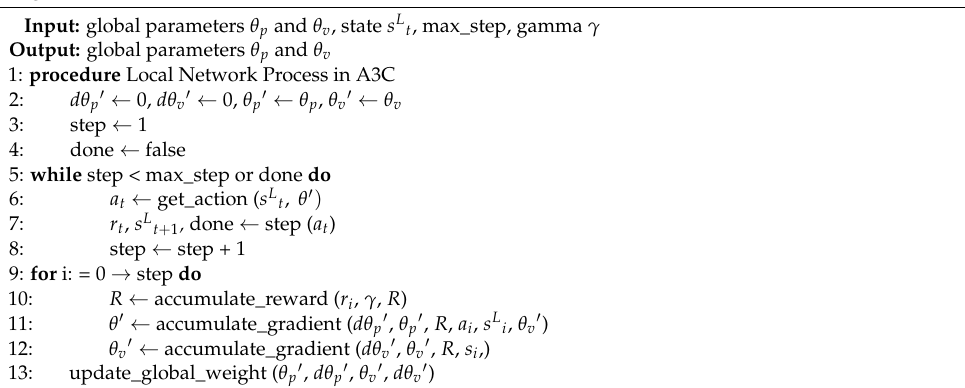
Algorithm 1 Local Network Process in A3C